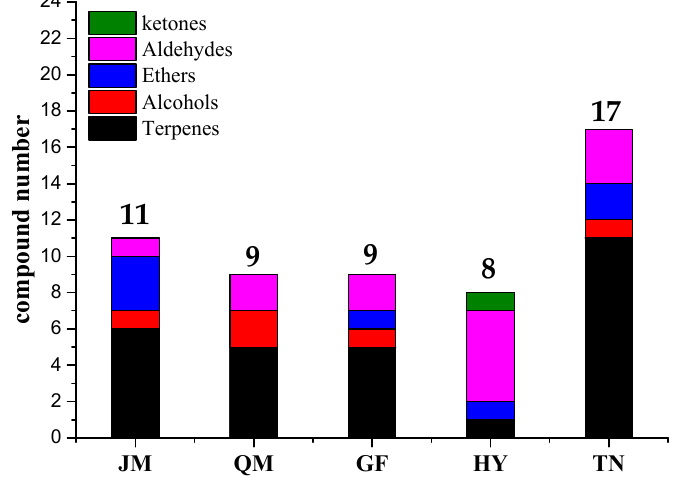
≥ 1 in five mango